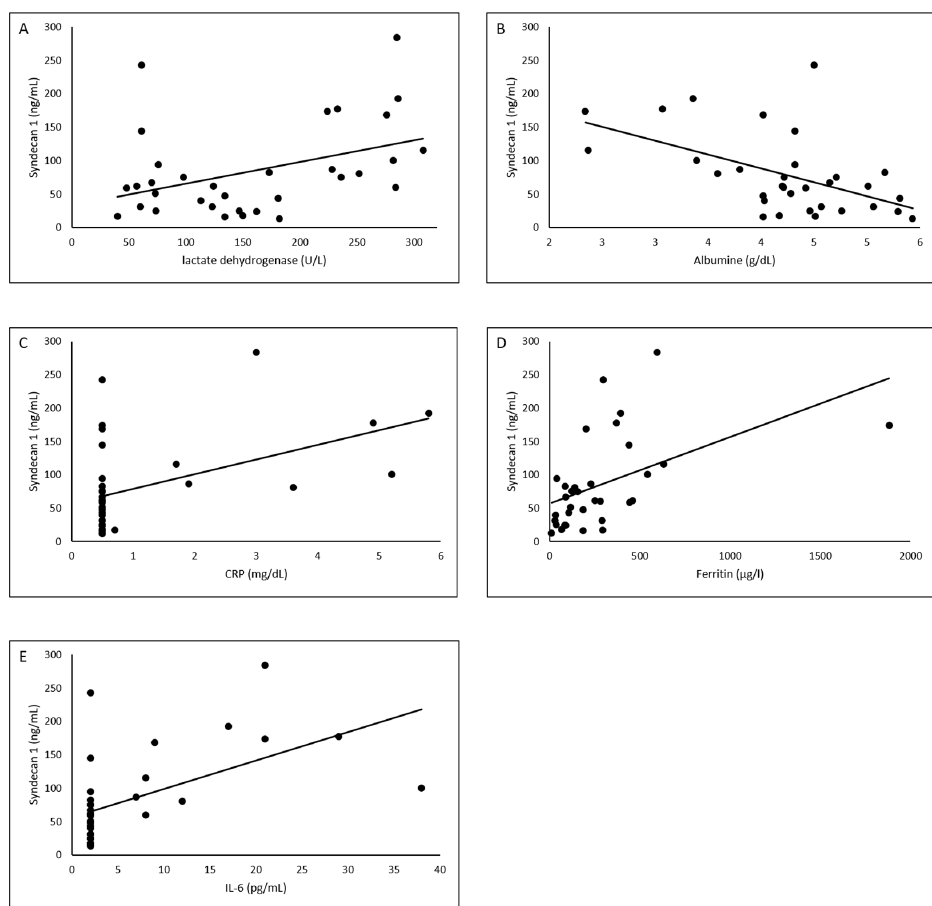
Figure 2. Significant correlations between SDC-1 levels and laboratory values in SARS CoV-2 patients, regression analysis plot. ( A ) lactate dehydrogenase, ( B ) albumine, ( C ) CRP, ( D ) ferritin, ( E ) Il-6